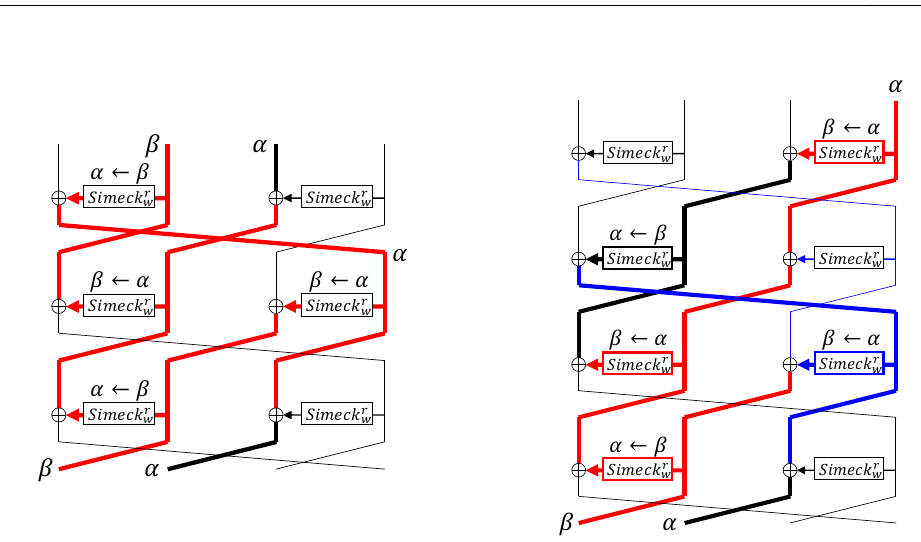
Figure 4: Left: Previous 3-Step Inbound Procedure for sLiSCP . Right: Improved 4-Step Inbound Procedure for sLiSCP . In the previous procedure, four active Simeck boxes are fixed independently, while in the new procedure, fixing three active Simeck boxes (red) will fix another one (blue), and an additional one (black) can be fixed